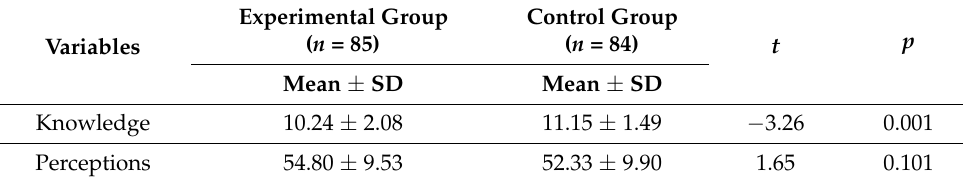
Table 2. Homogeneity test for main outcome variables between groups ( n =